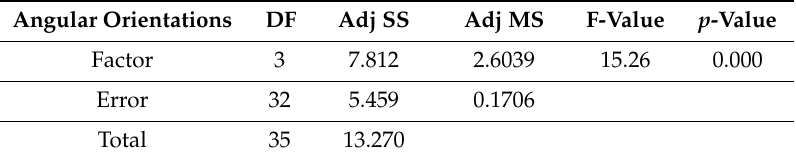
Table 30. ANOVA results for Ra as a function of angular orientations.